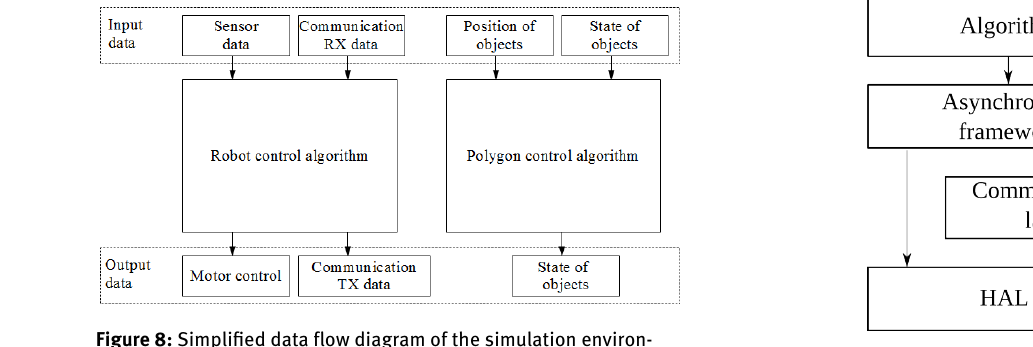
Figure 10: Robot firmware